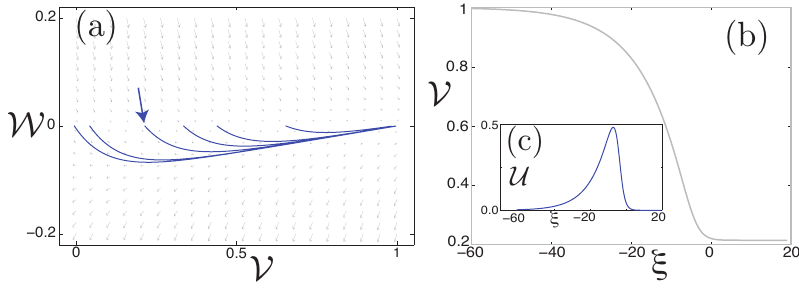
Fig. 1 (a) Heteroclinic orbits of Eq. (10) for β = 0 . 1. (b) Kink solution for β = 0 . 1 corresponding to the marked heteroclinic orbit in (a). (c) The bright soliton solution U corresponds to the kink obtained in